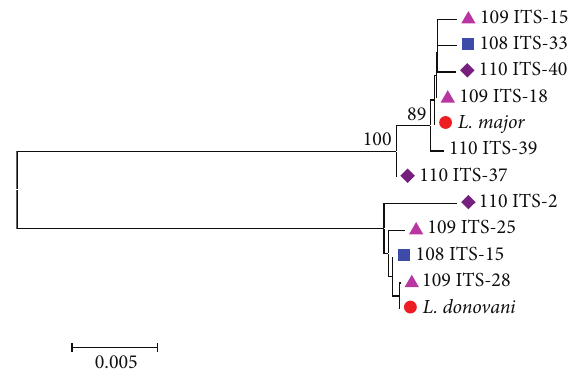
Figure 4: Phylogenetic tree of ITS cloning sequences. Phylogenetic tree (unrouted) based on a fragment of 970 bp of ITS gene of Leishmania parasite. Sequence dataset was analyzed using MEGA 5, the neighbor-joining (NJ) method, and bootstrap analysis (1,000 replicates) based on the ClustalW algorithm. Significant bootstrap- ping values ( > 70%) are shown on the nodes. Blue square: colonies numbers 15 and 33 as representative sequences of 108 ITS cloned sample; pink triangle: colonies numbers 15, 18, 25, and 28 as representative sequences of 109 ITS cloned sample; purple lozenge: colonies numbers 2, 37, 39, and 40 as representative sequences of 110 ITS cloned sample; red circle: Leishmania GenBank reference sequence ( L. donovani GenBank accession number AJ634357; L. major GenBank accession number